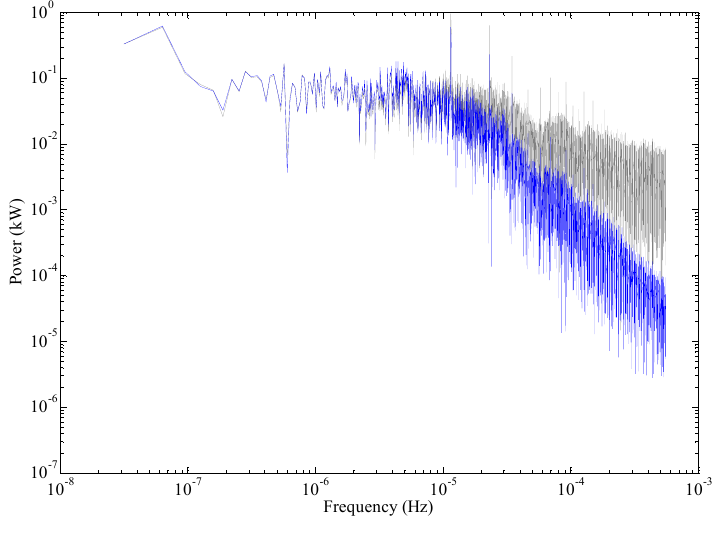
Figure 7. Frequency spectrum of the power profile exchanged with the grid without applying any strategy (grey) and once the strategy is applied